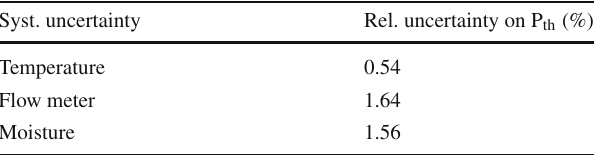
Table 1 Contributions to the uncertainty of the thermal power P th esti- mation from the energy balance in the secondary circuit Syst. uncertainty